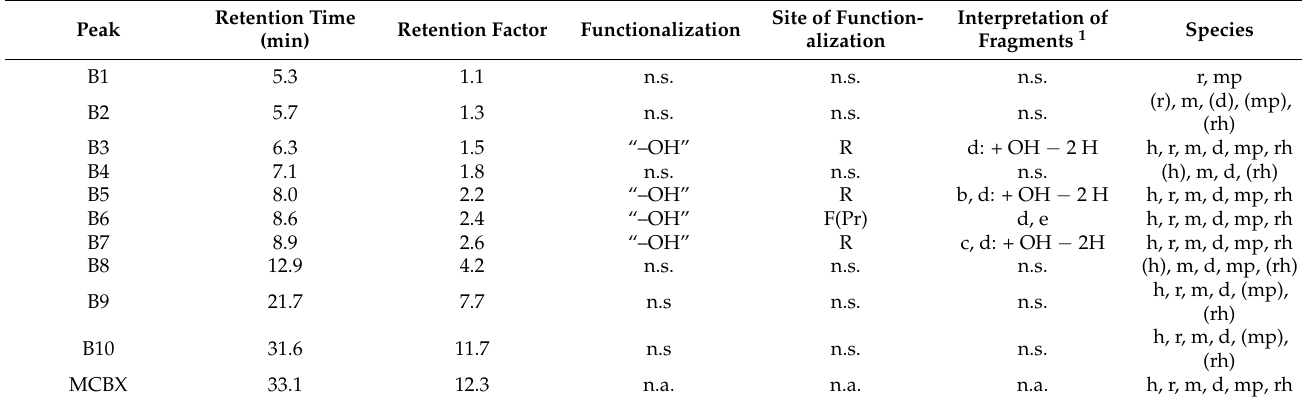
Table 3. Metabolites of MCBX generated in liver microsomes from various species.